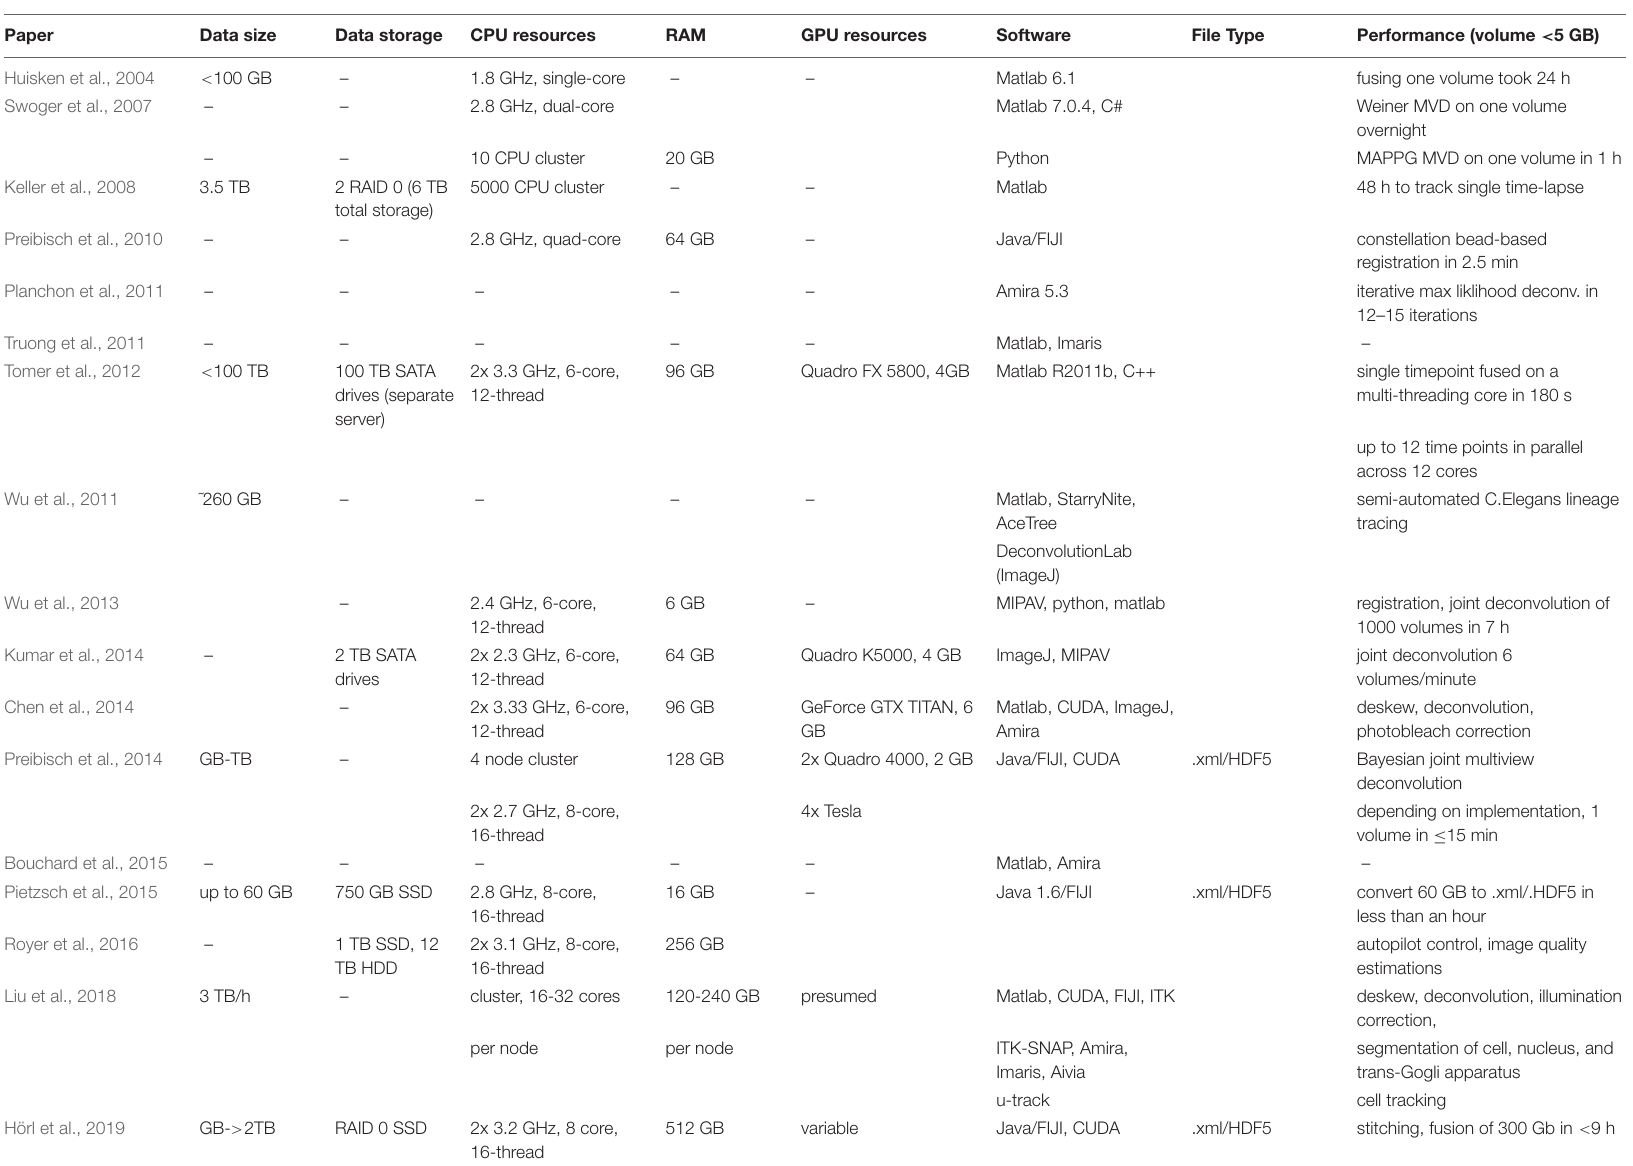
TABLE 1 | Sampling of light-sheet computing